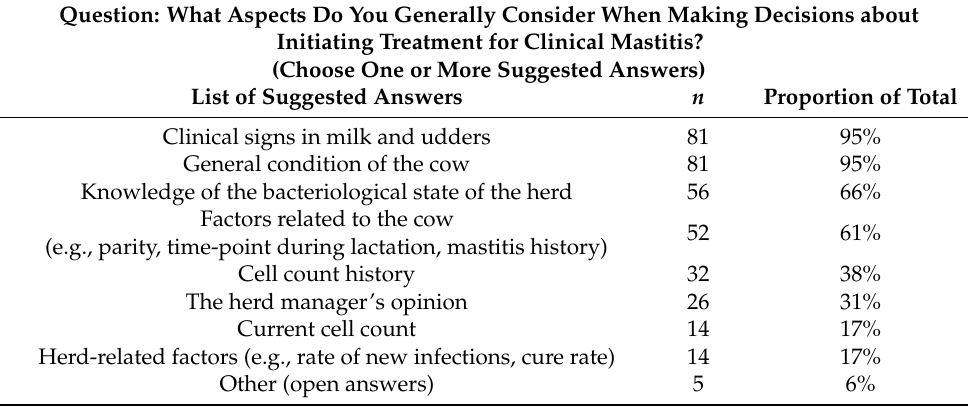
Table 1. Number ( n ) and proportion (%) of respondents who marked the suggested answers often considered when making decisions about initiating treatment. Based on answers from 85 Dan- ish veterinarians.